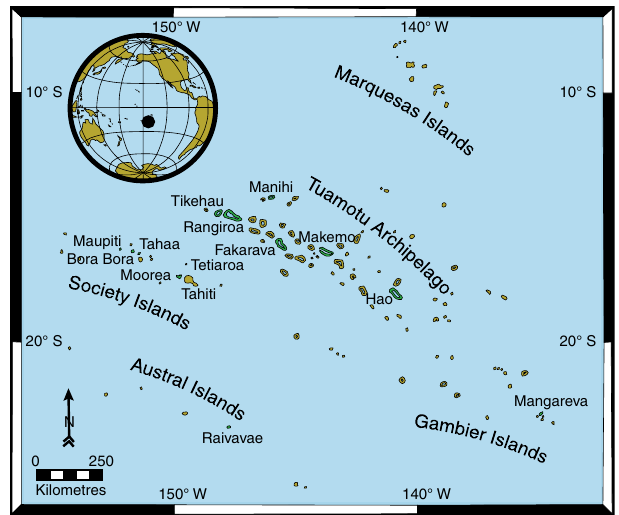
Fig. 1 Map of French Polynesia. Modern and Holocene reef systems have been studied on 12 islands from four archipelagos (Tuamotu, Society, Gambier and Austral islands) in French